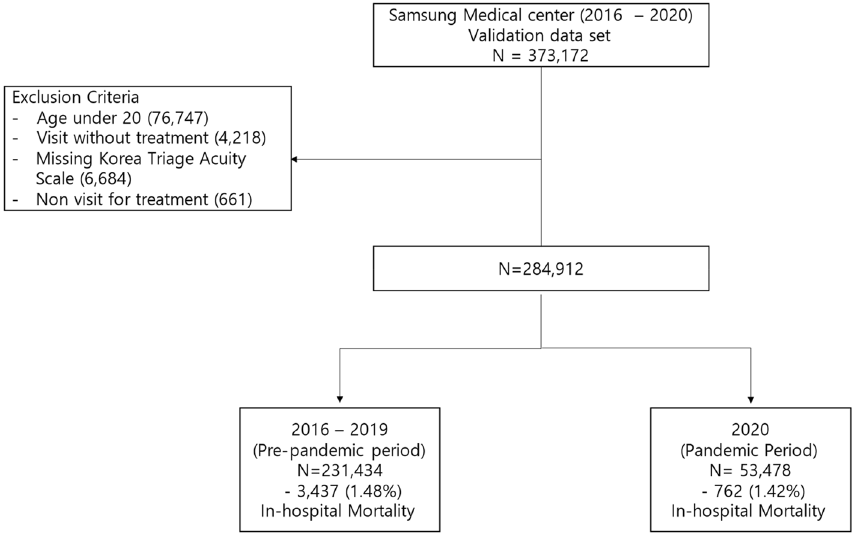
Figure 1. Flow chart of the study